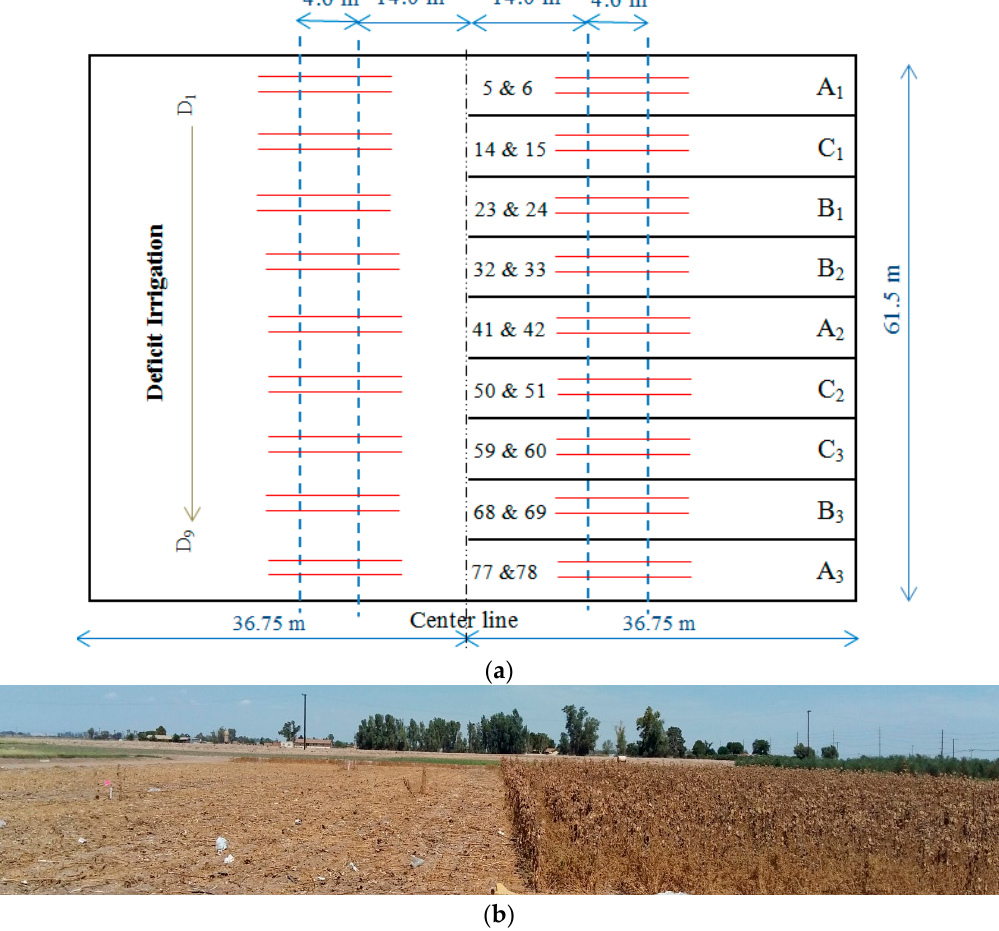
Figure 5. ( a ) Illustration of the 18 harvest sections (nine from the eastern section + nine from the western deficit section) with a length 4.6 m and taken from the two middle rows for each zone; specific row numbers are indicated. ( b ) Shredding of the stalks of one of the field sections following harvest.